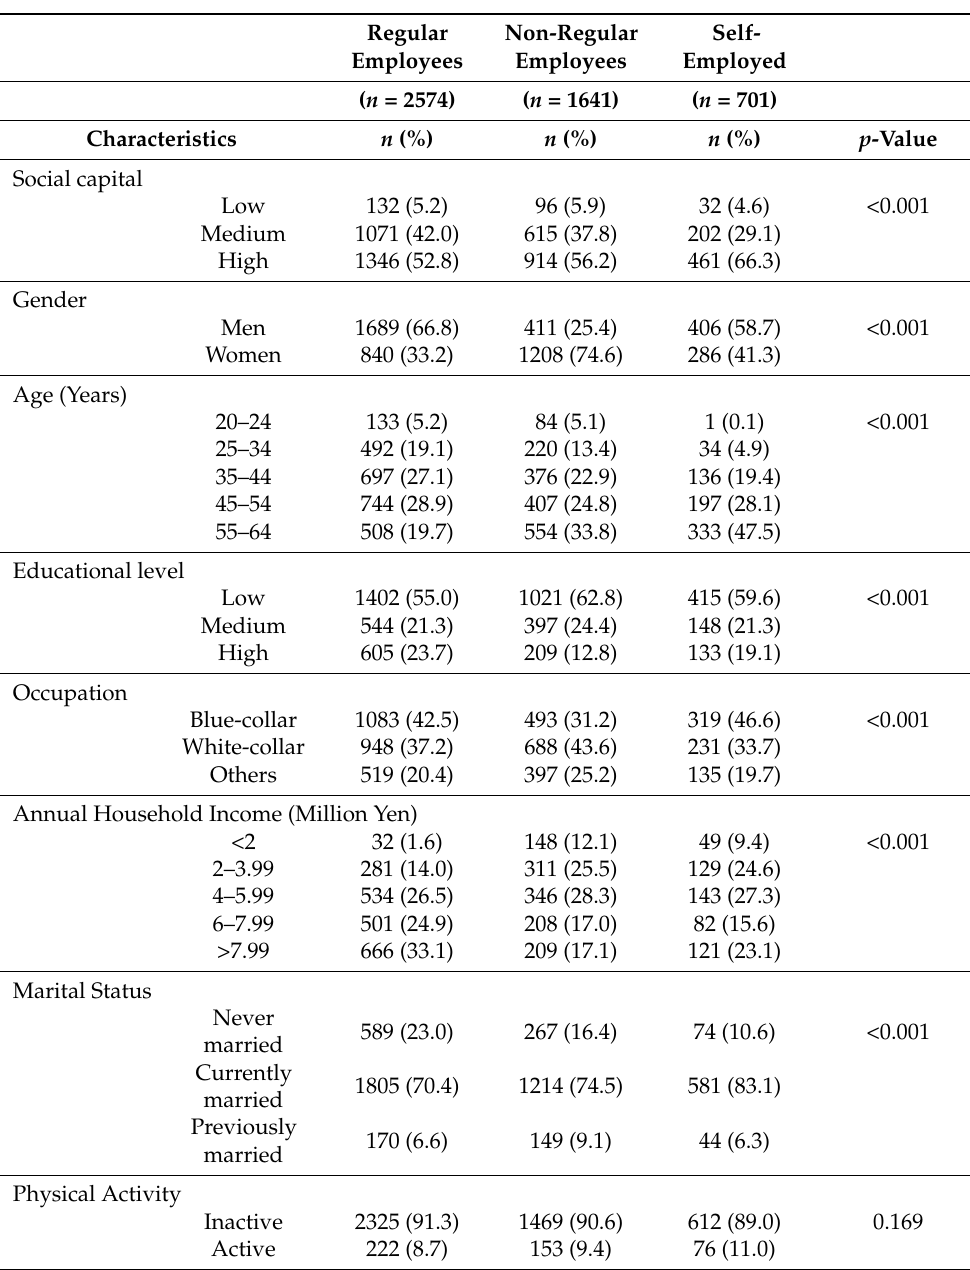
Table 1. Demographic characteristics of respondents according to employment